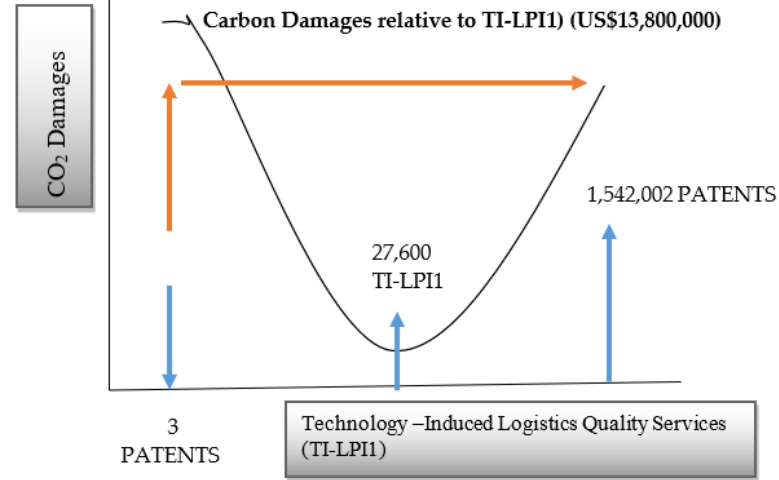
Figure 6. Moderation U-shaped Curve between Carbon Damages and Technology Induced Logistics Performance Indices (LPI1 × PATENTS).